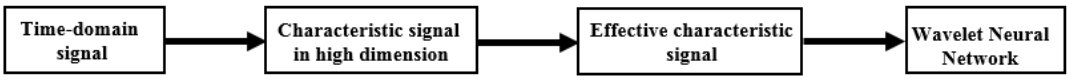
Figure 1. The fault diagnosis method based on a manifold learning and a neural network.